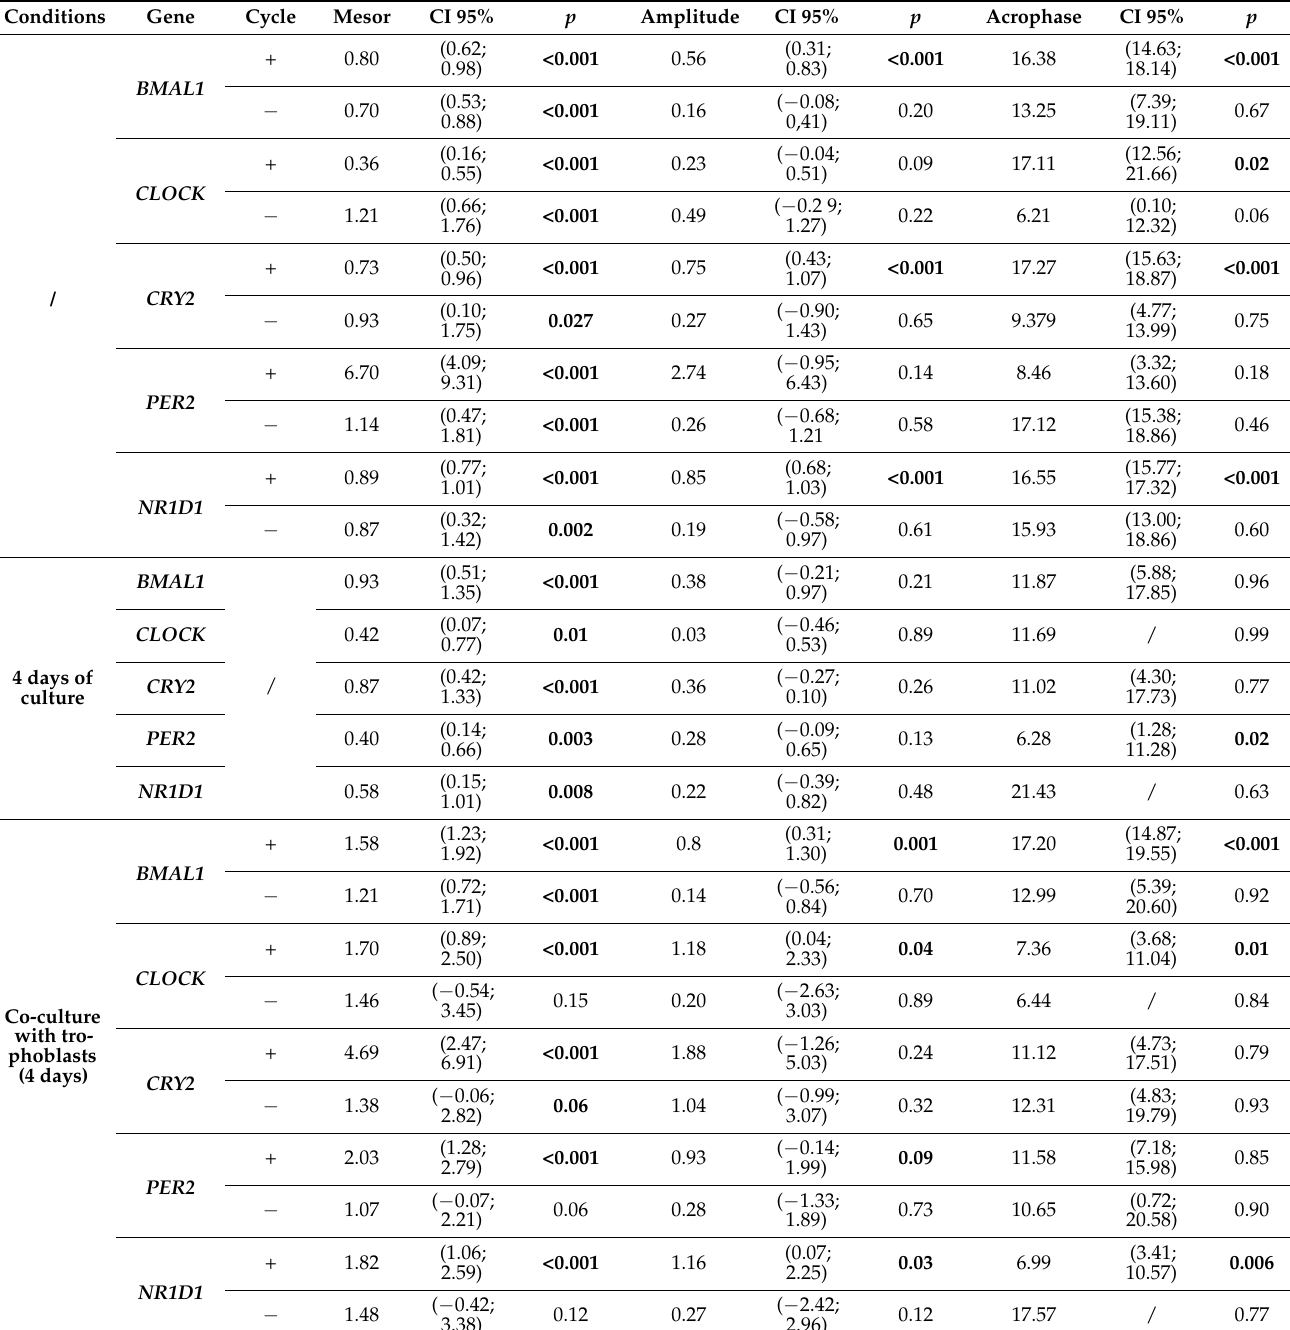
Table 1. Rhythmic parameters (mesor, amplitude and acrophase) for placental macrophages. A p value < 0.05 for mesor, amplitude, and acrophase implies a rhythmicity of the investigated